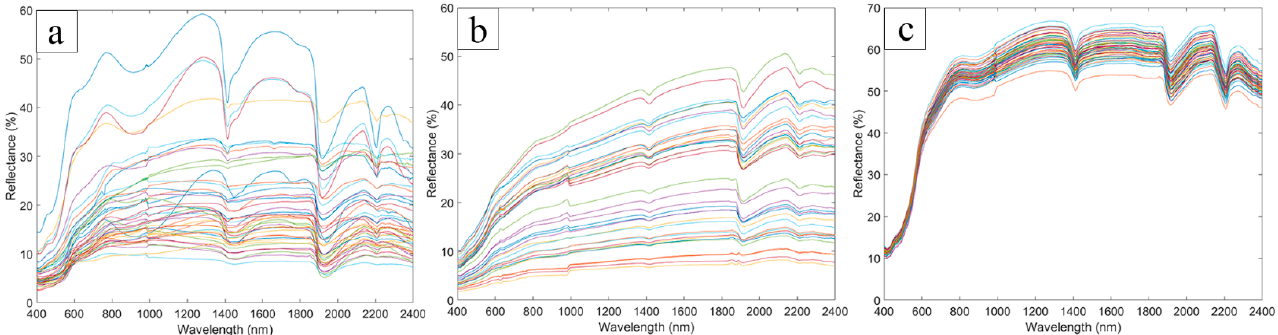
Figure 4. The spectra of different sample sets: ( a ) Hengyang; ( b ) Baoding; and ( c ) NSS Cd.